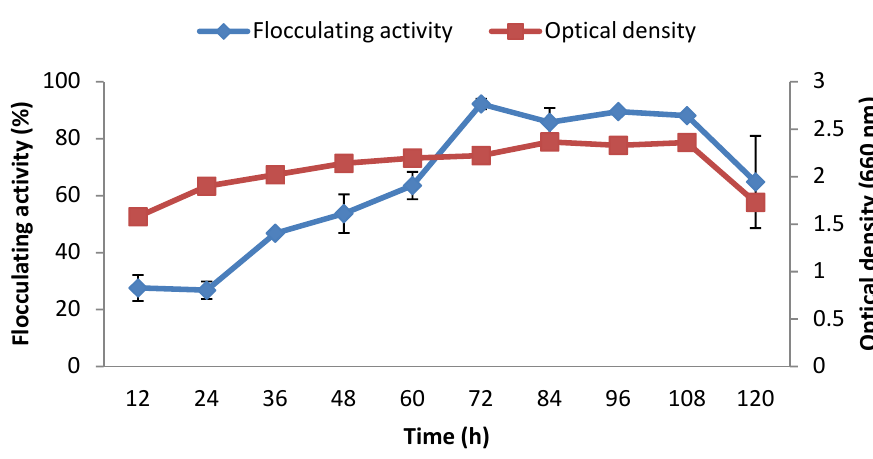
Figure 6. Growth and bioflocculant production curves of Cobetia sp.